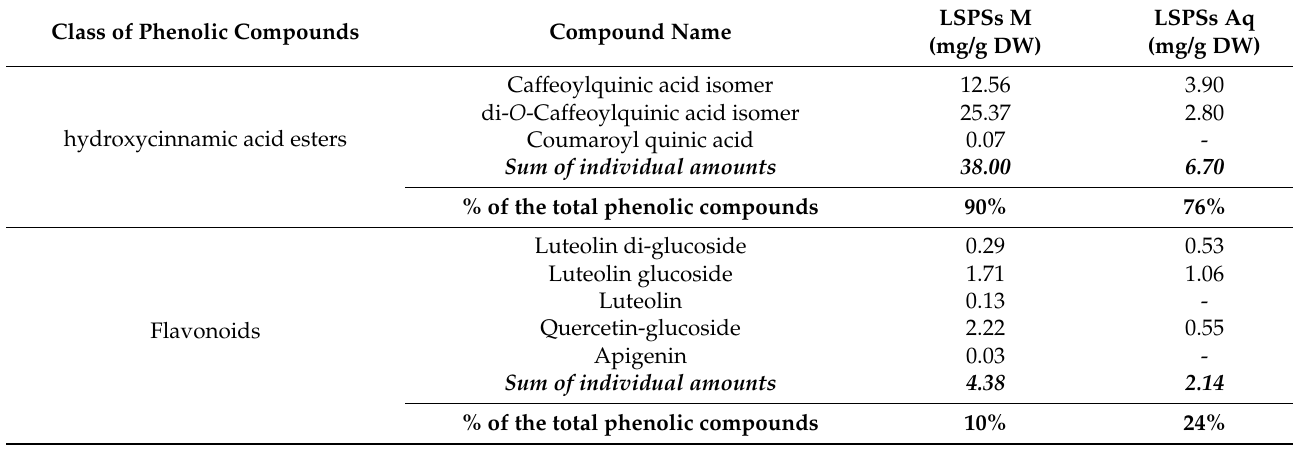
Table 4. Amounts and percentages of phenolic compounds contained in methanolic and aqueous extracts of P. saxatile , identified by HPLC-DAD-ESI/MS n